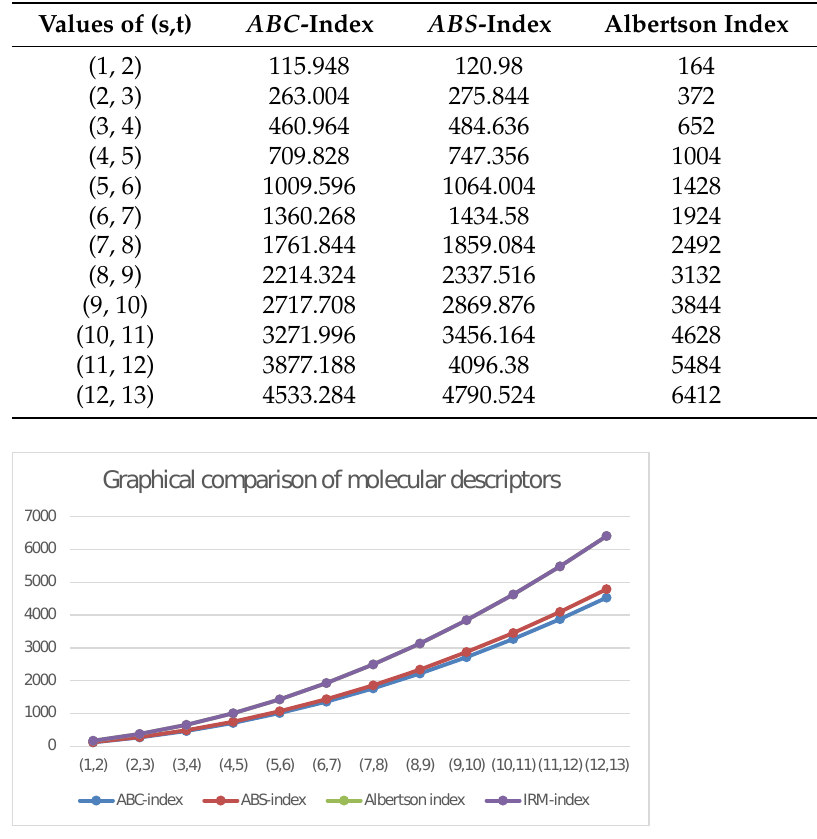
Figure 5. Graphical Comparison of ABC -index, ABS -index, Albertson index and IRM